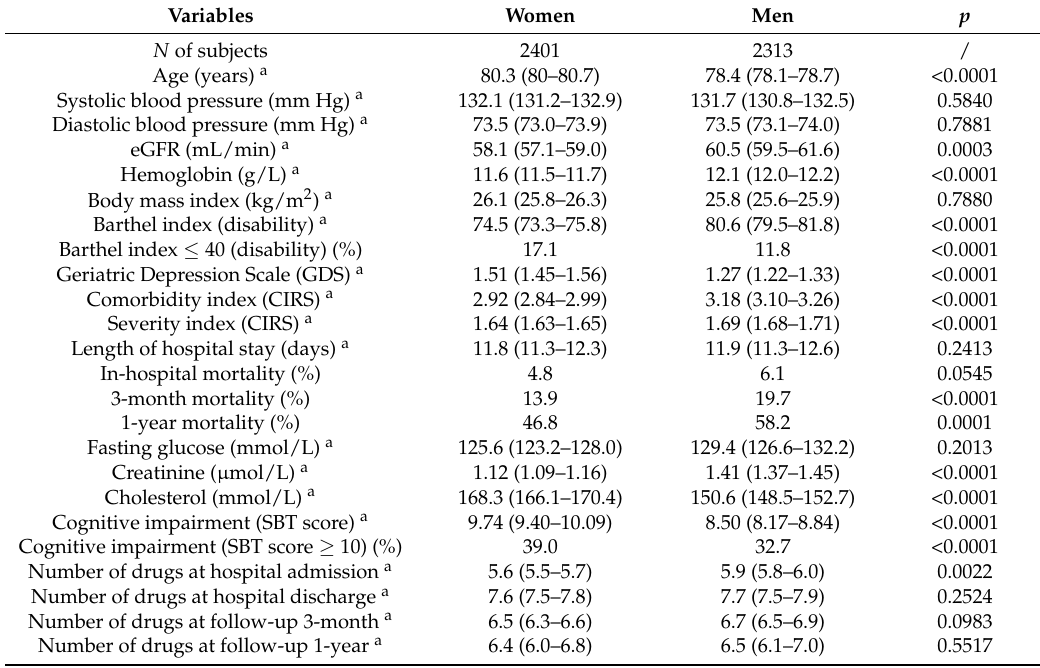
Table 1. Clinical characteristics of the RePoSi population at hospital admission.